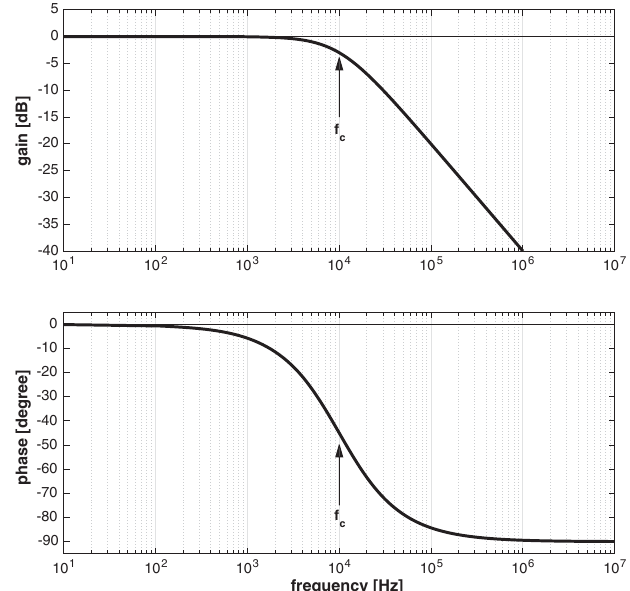
FIG. 2. Example of the Bode plot of a low-pass filter. One can see that at the cutoff frequency (here 10 kHz), the gain is − 3 dB and the phase shift is − 45 °. It is also clear that the phase shift will be limited to − 90 °.